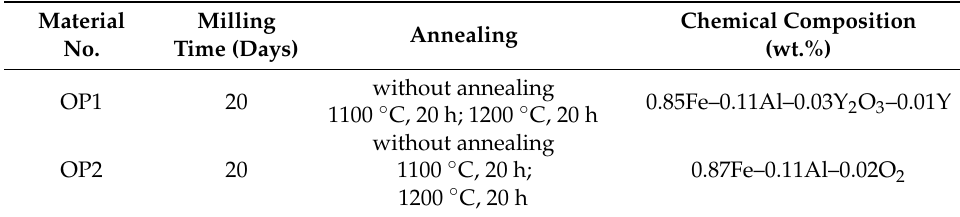
Table 1. Material parameters for rolled and forged